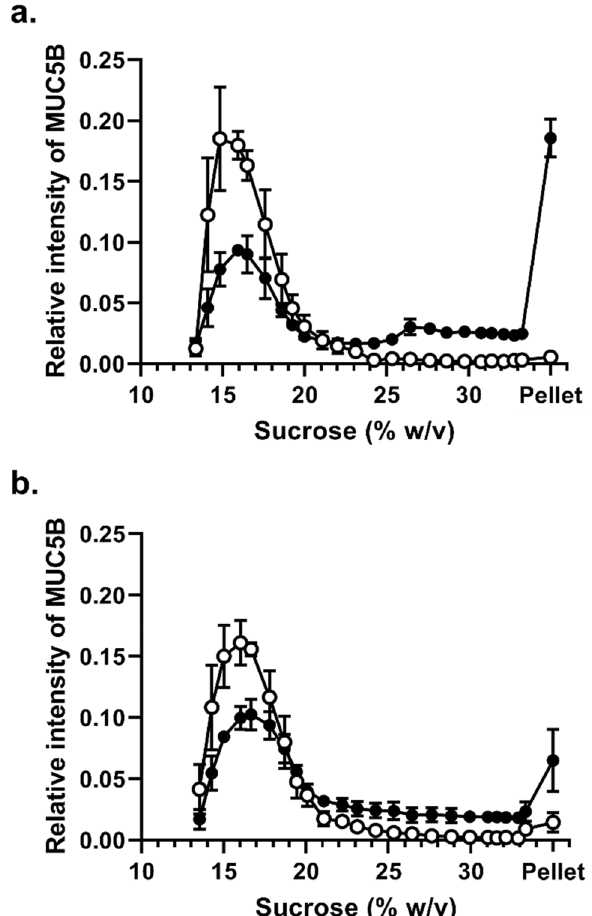
Figure 3. Concentration-dependence of MUC5B on CsA mediated aggregation. Rate-zonal centrifugation in 10–35% (w/v) sucrose gradients of purified MUC5B ( a 100 μg/mL, b 400 μg/mL) alone (white) or with 1 mM CsA (black). Mucins were detected in sucrose gradient fractions after slot blotting by the mucin-specific antibody probe, EUMUC5B. Band intensities were quantified using the Odyssey Imaging system. The results are presented as the mean ± s.e.m. (n = 3) from 3 independent experiments.